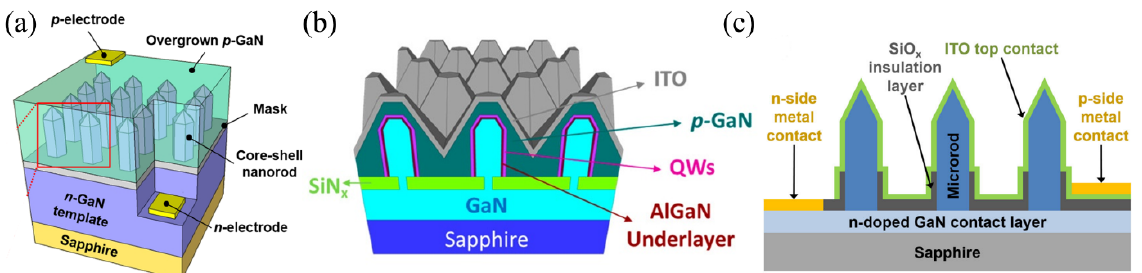
Figure 2. Schematic microrod chip structures with different top contact solutions. ( a ) Coalescent p-GaN. Reprinted with permission from Ref. [37]. Copyright 2016, Jung et al. ( b ) Coalescent p-GaN and ITO. Reprinted with permission from Ref. [1]. Copyright 2019 American Chemical Society. ( c ) ITO. Reprinted with permission from Ref. [3]. Copyright 2016 WILEY-VCH Verlag GmbH & Co. KGaA, Weinheim.